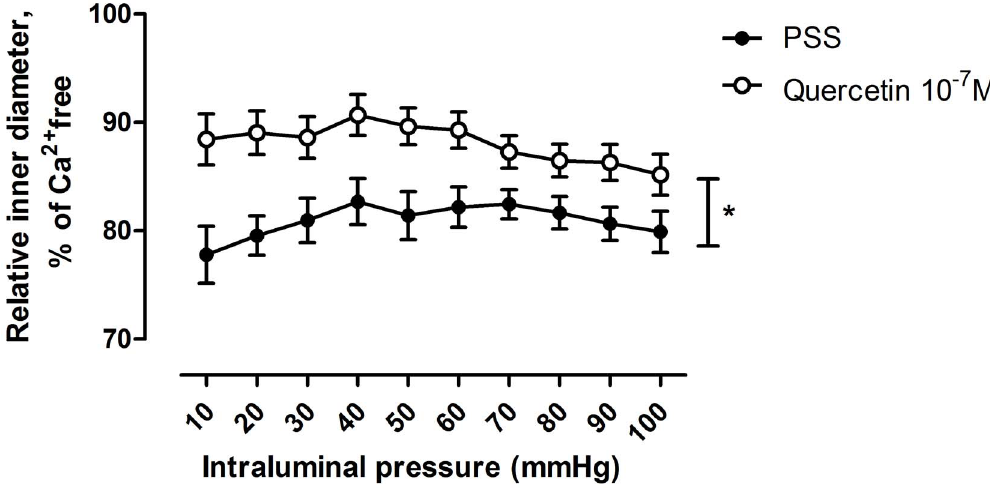
Figure 2. Quercetin dilation on spontaneously contracted small coronary arterioles at different pressures. Full circles represents diameters in PSS, empty circles are diameters in quercetin 10 2 7 moles/lit. * p , 0.05 with